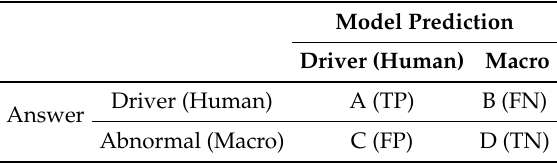
Table 6. Matrix of number of